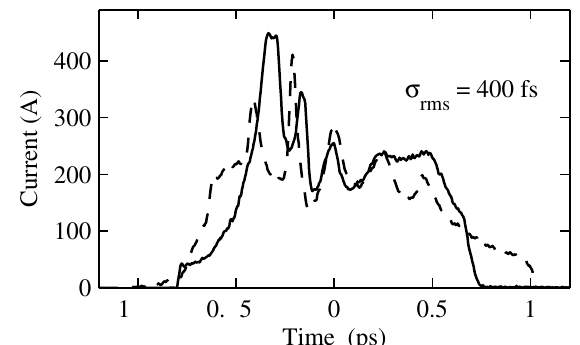
FIG. 4. Current profile measured by zero phasing. The two curves represent two measurements separated by 180. The ripples at the peak are most likely due to small energy modu- lation; they do not necessarily represent spikes in the time domain [14].